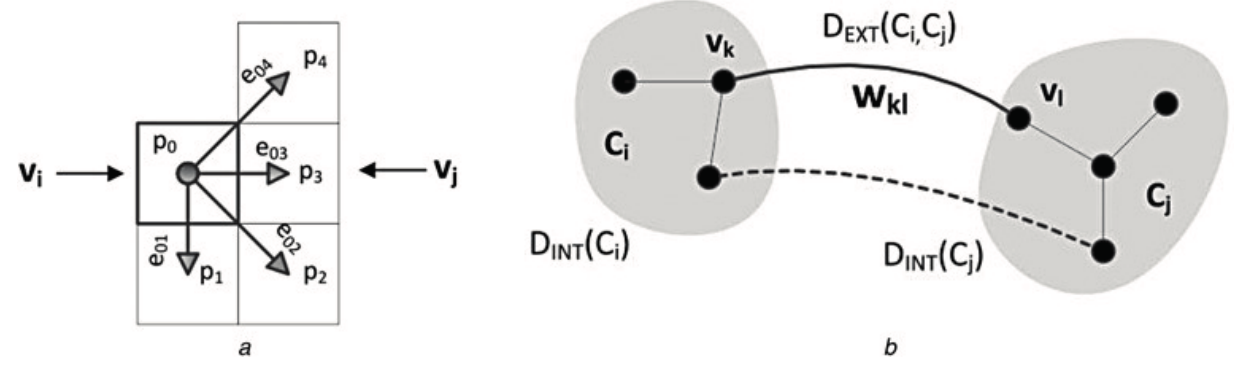
Figure 4. Principle of graph-based image segmentation (referred from [60]) based on an image graph and its components: ( a ) edges between the pixels and its weight, ; ( b ) relationships of the internal distance, (cid:1830) , (cid:1861) = 1, … ,4 for any image pixel (cid:1842) (cid:1857) (cid:2868)(cid:3036) (cid:2868) mutual external distance, (cid:1830) , between two spanning tree elements, (cid:1829) (cid:3006)(cid:3025)(cid:3021) is the absolute distance of the RGB vector between the two vertices and not the Euclidean distance in